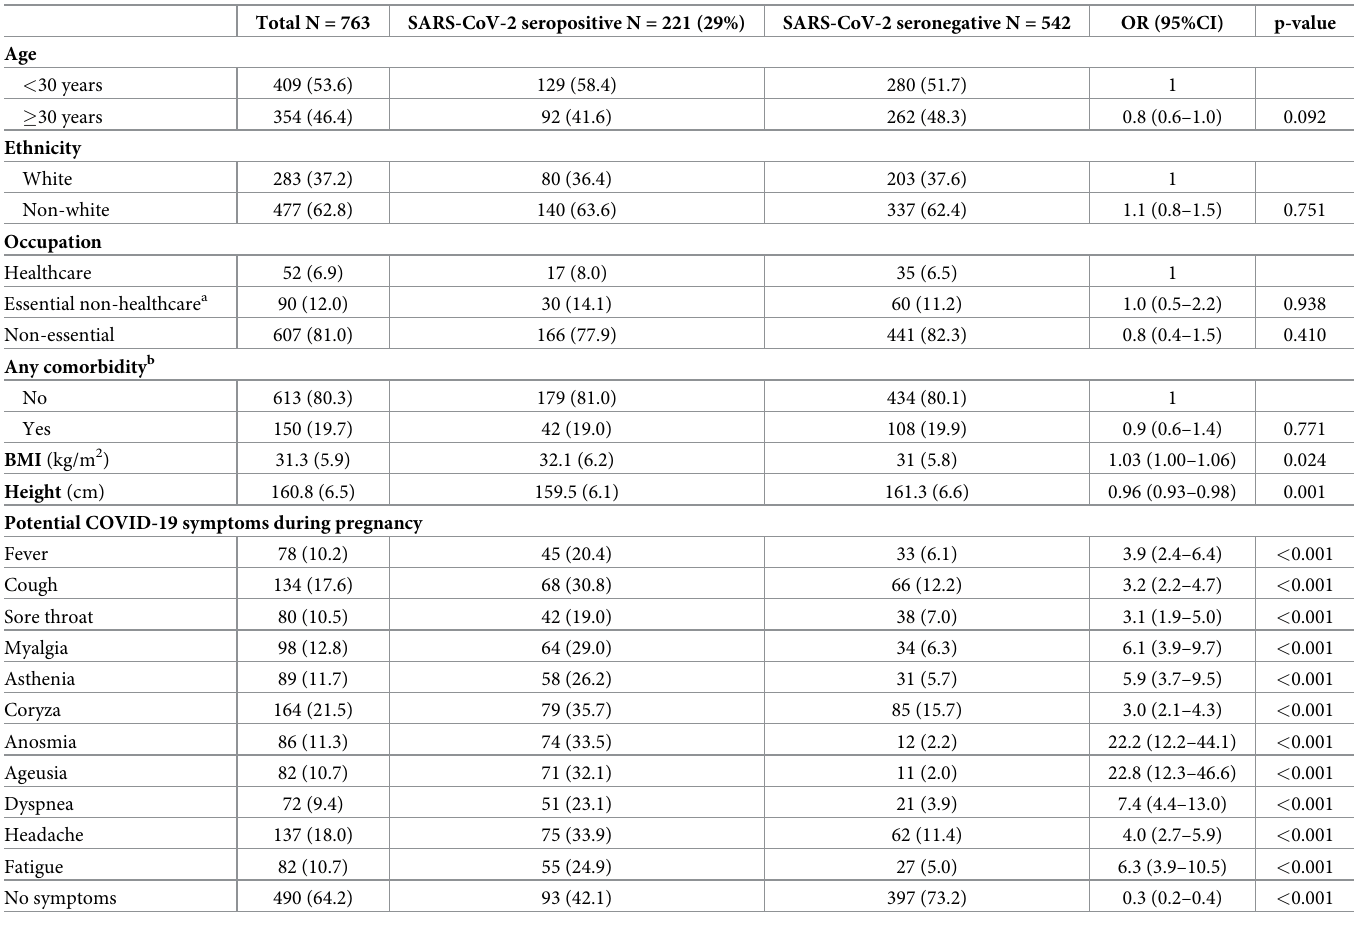
Table 2. Factors associated with SARS-CoV-2 seropositivity by